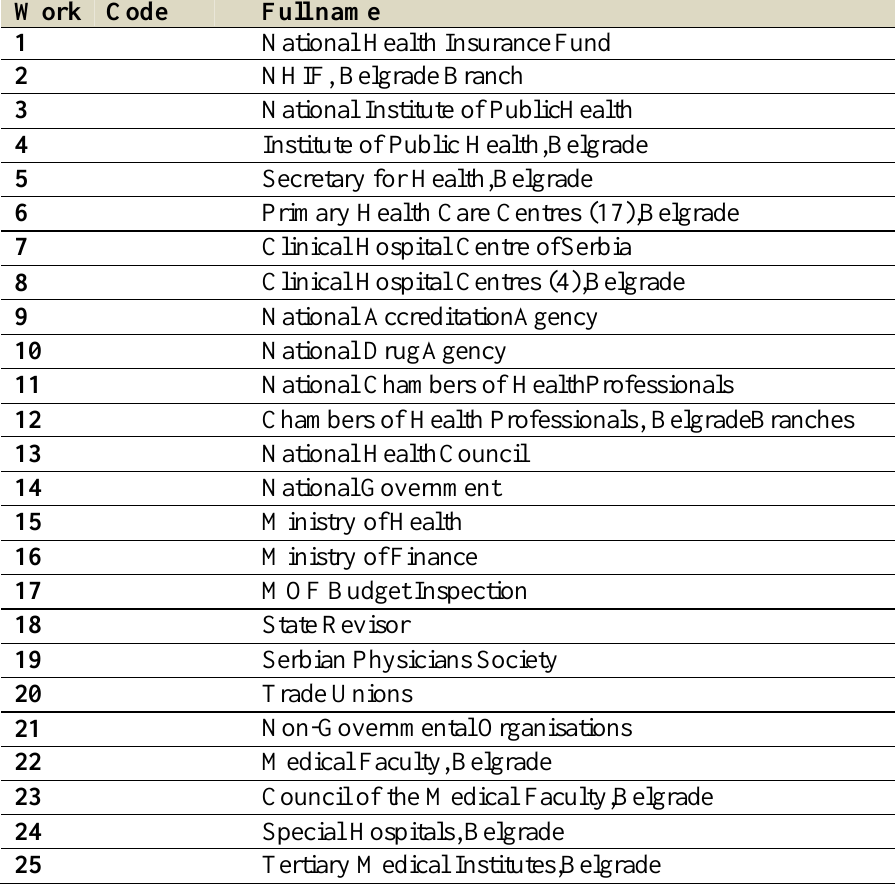
Table 3. List of Players and their